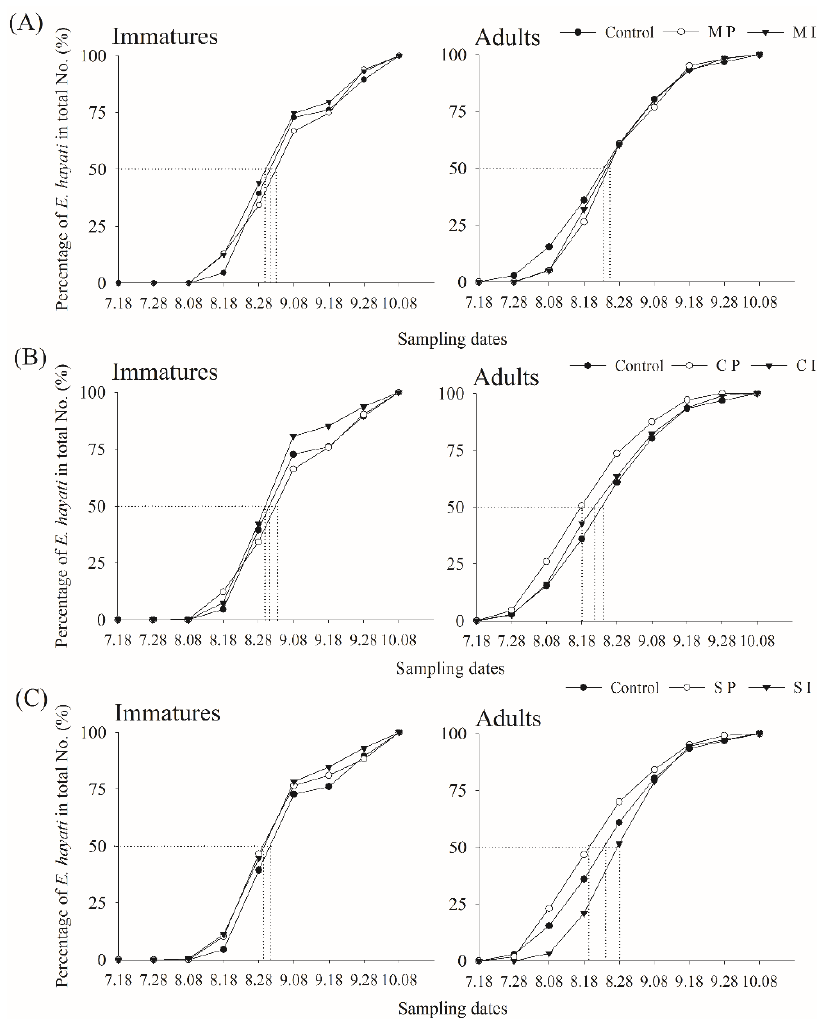
Figure 2. Cumulative seasonal activity curves of Eretmocerus hayati in cotton with inter- or perimeter-cropped maize ( A ), cantaloupe ( B ), and sunflower ( C ) at Langfang, Hebei Province, northern China, in 2012.